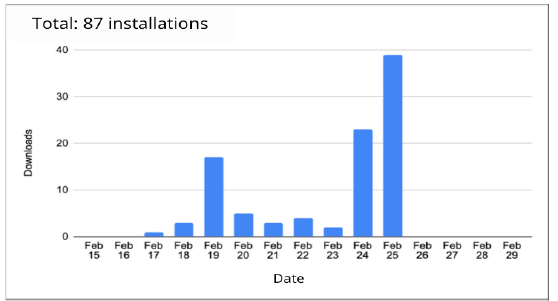
Figure 7. Installations chart on IOS devices